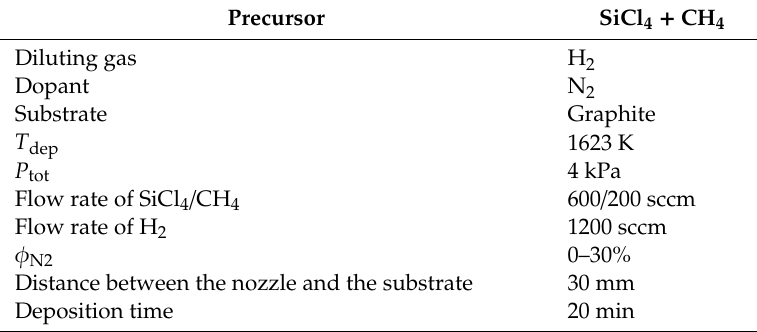
Figure 1. Schematic illustration of the HLCVD apparatus. Table 1. Deposition